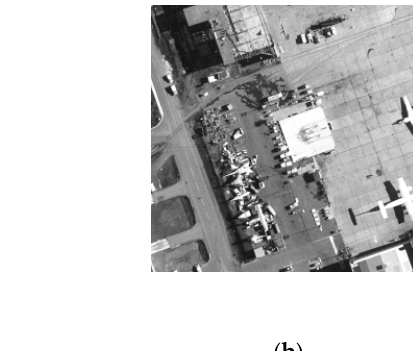
Figure 3. Two images with different resolutions: ( a ) 512 (cid:3400) 512 pixels and ( b ) 256 (cid:3400) 256 pixels.